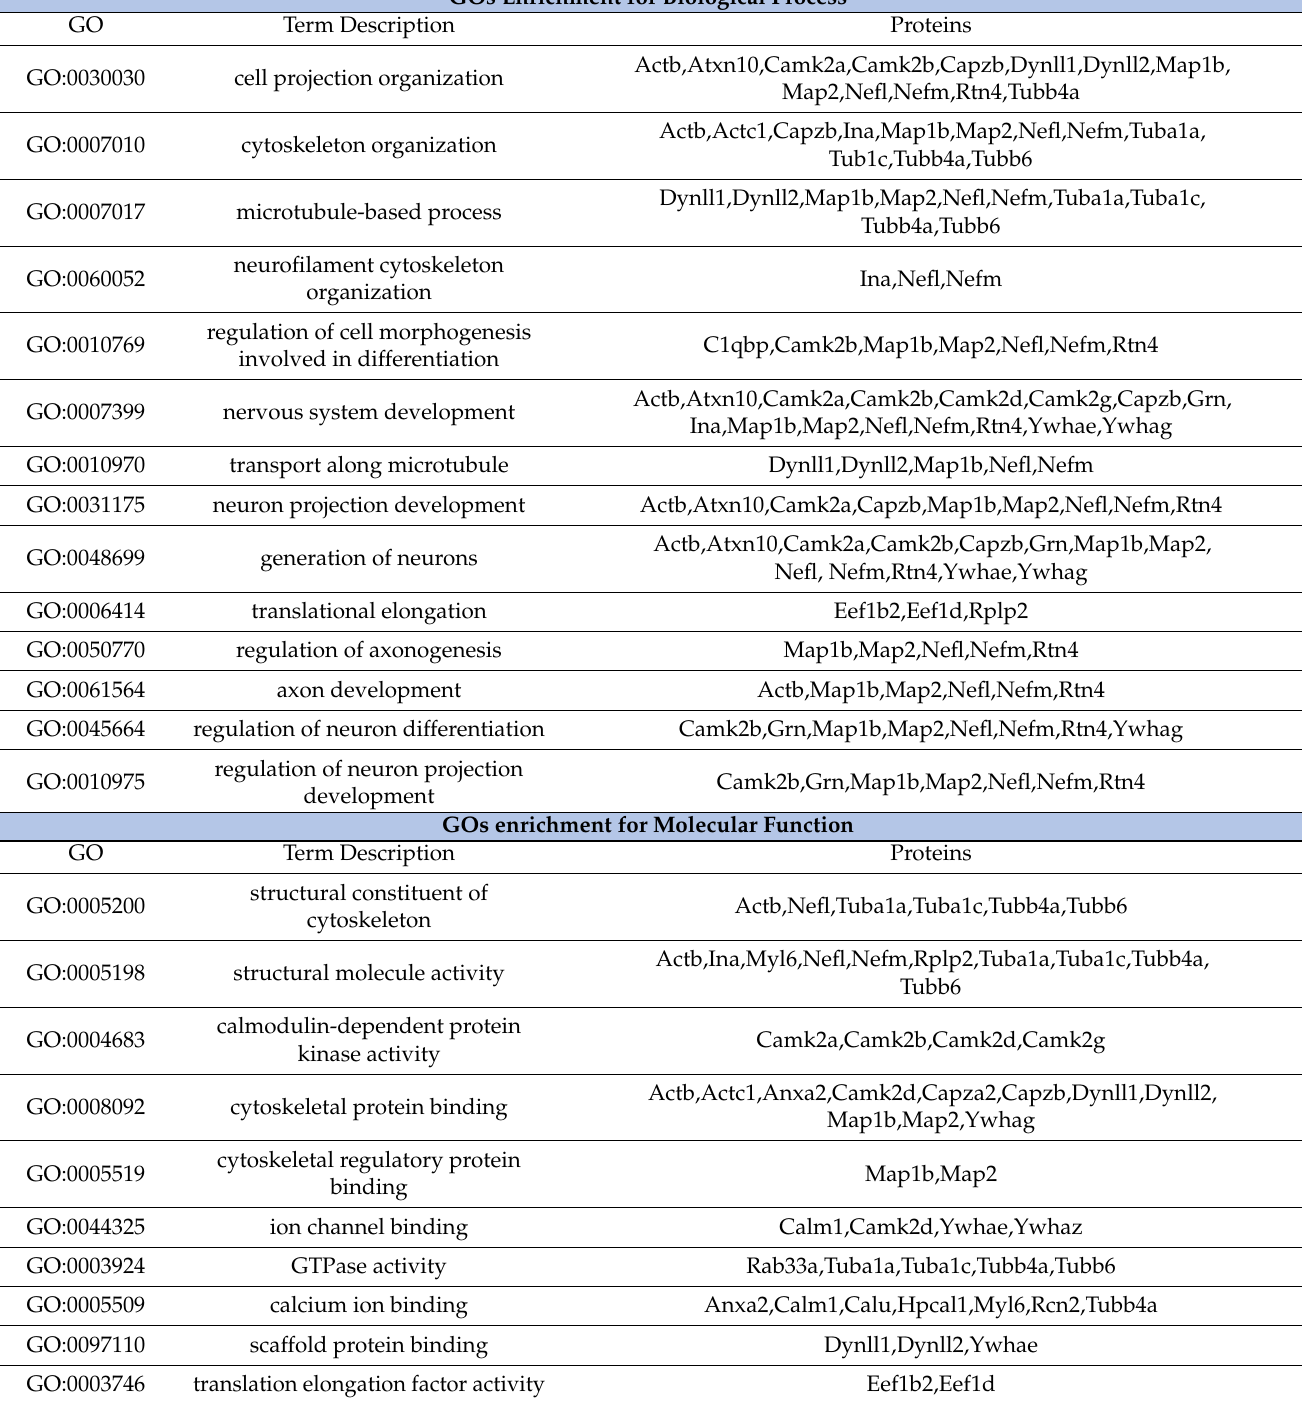
Table 2. Gene Ontology (GO) terms enriched for Biological Process, Molecular Function and Cellular Components in the NCAM2